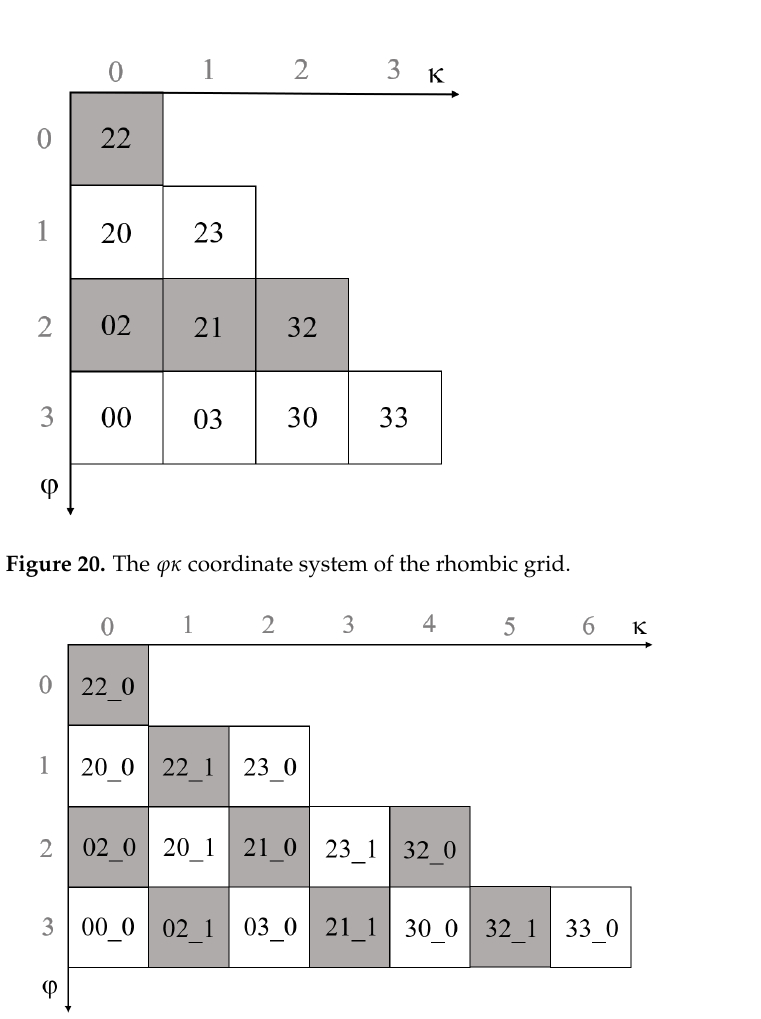
15 of 23 Figure 19. Linear quadtree encoding based on Morton encoding coordinate System. (1) Calculation of row–column number